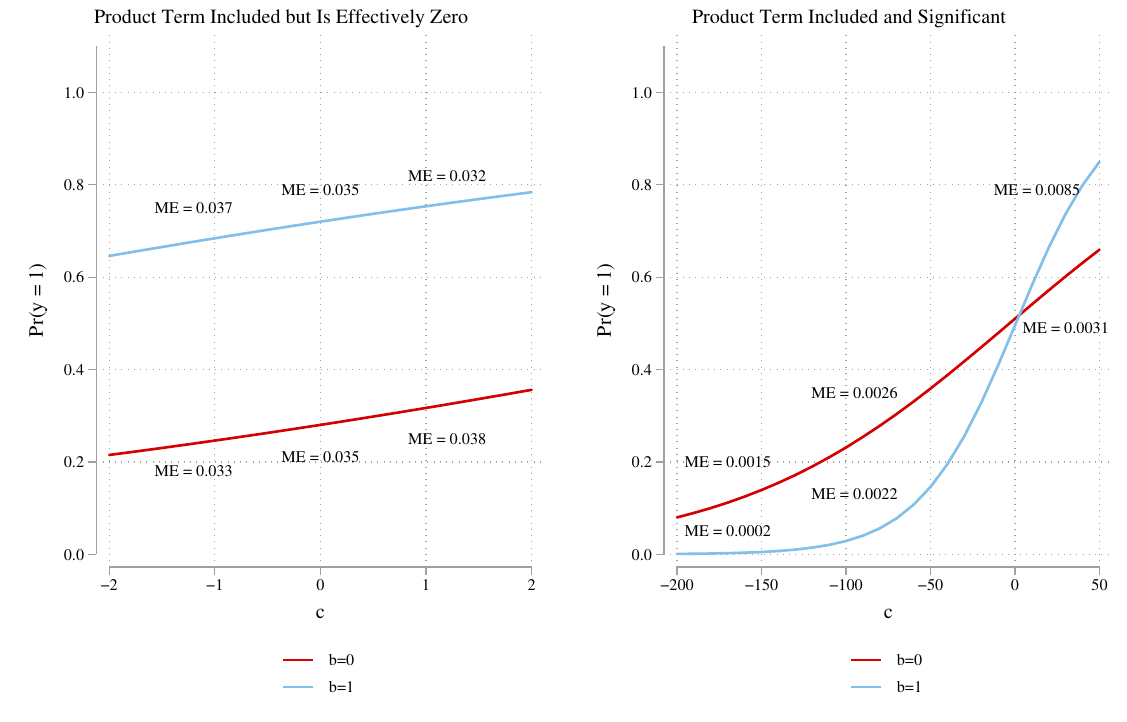
Figure 11: Interaction effect on the predicted probabilities cannot be determined by examining the coefficient of the product term: different parts of data